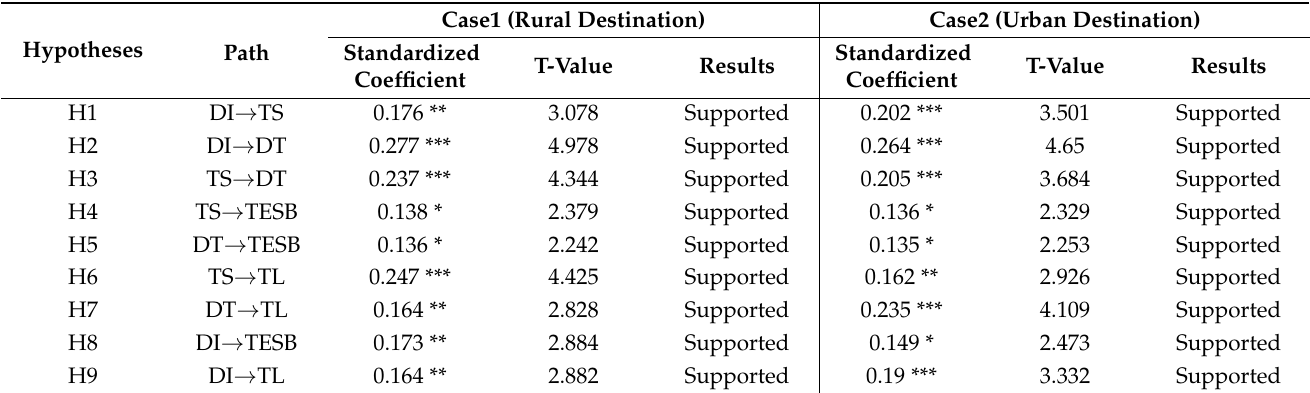
Table 4. Structural model assessment and hypothesis test outcome.